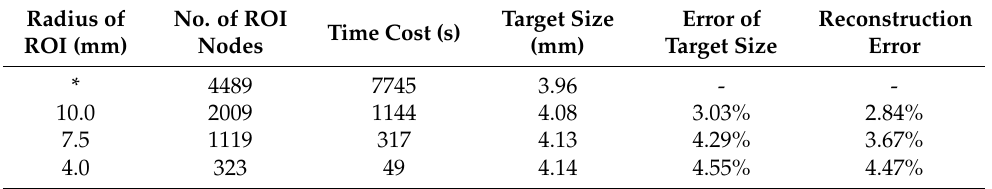
Figure 3. Acceleration performance and fitted curves of the localized FE-PAT algorithm in terms of the relative radius ( a ) and the relative number of nodes ( b ) in the ROI. The ordinates are based on a logarithmic scale.